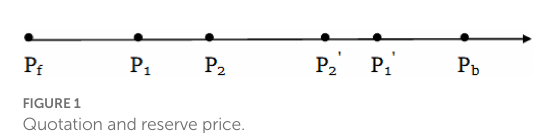
FIGURE 1 Quotation and reserve price.